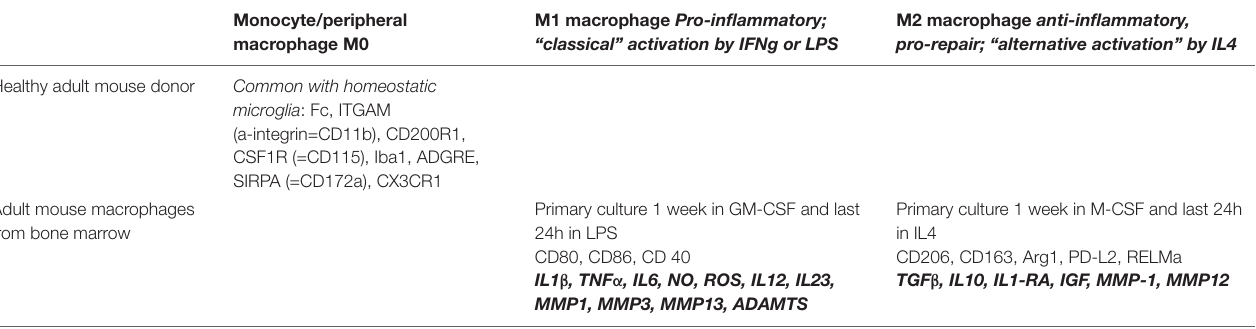
Monocyte/peripheral macrophage